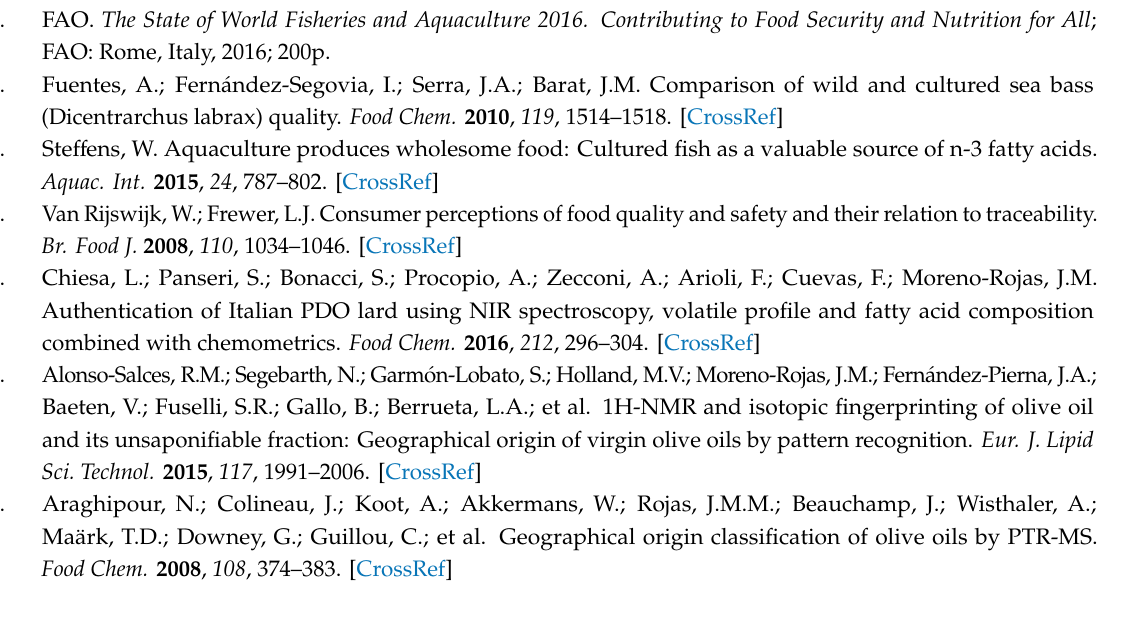
Figure S1: Isotope ratios in annual average precipitation for hydrogen and oxygen. Location of the 11 sea bass farms along the Italian coasts are